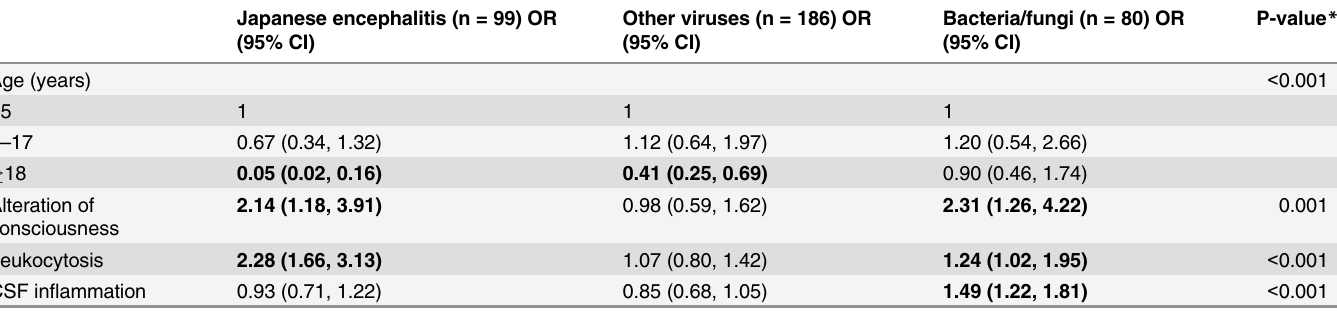
Table 6. Final multinomial logistic regression model predicting AME. Negative cases (n = 176) are the reference group. Japanese encephalitis (n = 99) OR (95%